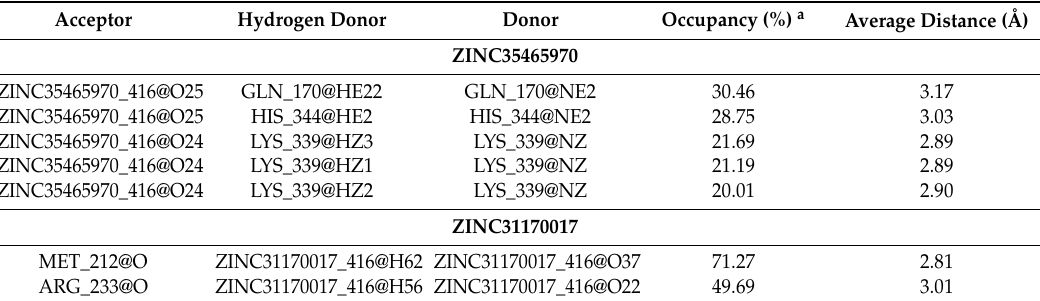
Table 4. Hydrogen bonds formed in complexes.